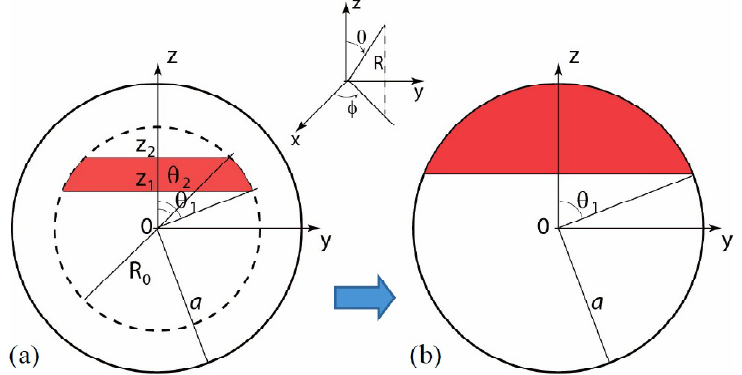
Fig. 2. A geometric scheme for the elastic problem for a Janus particle. (a) Dilatation inclusion in the form of a truncated spherical segment in a spherical particle. (b) Janus particle. The figures show the sectional plane x =0 of a spherical